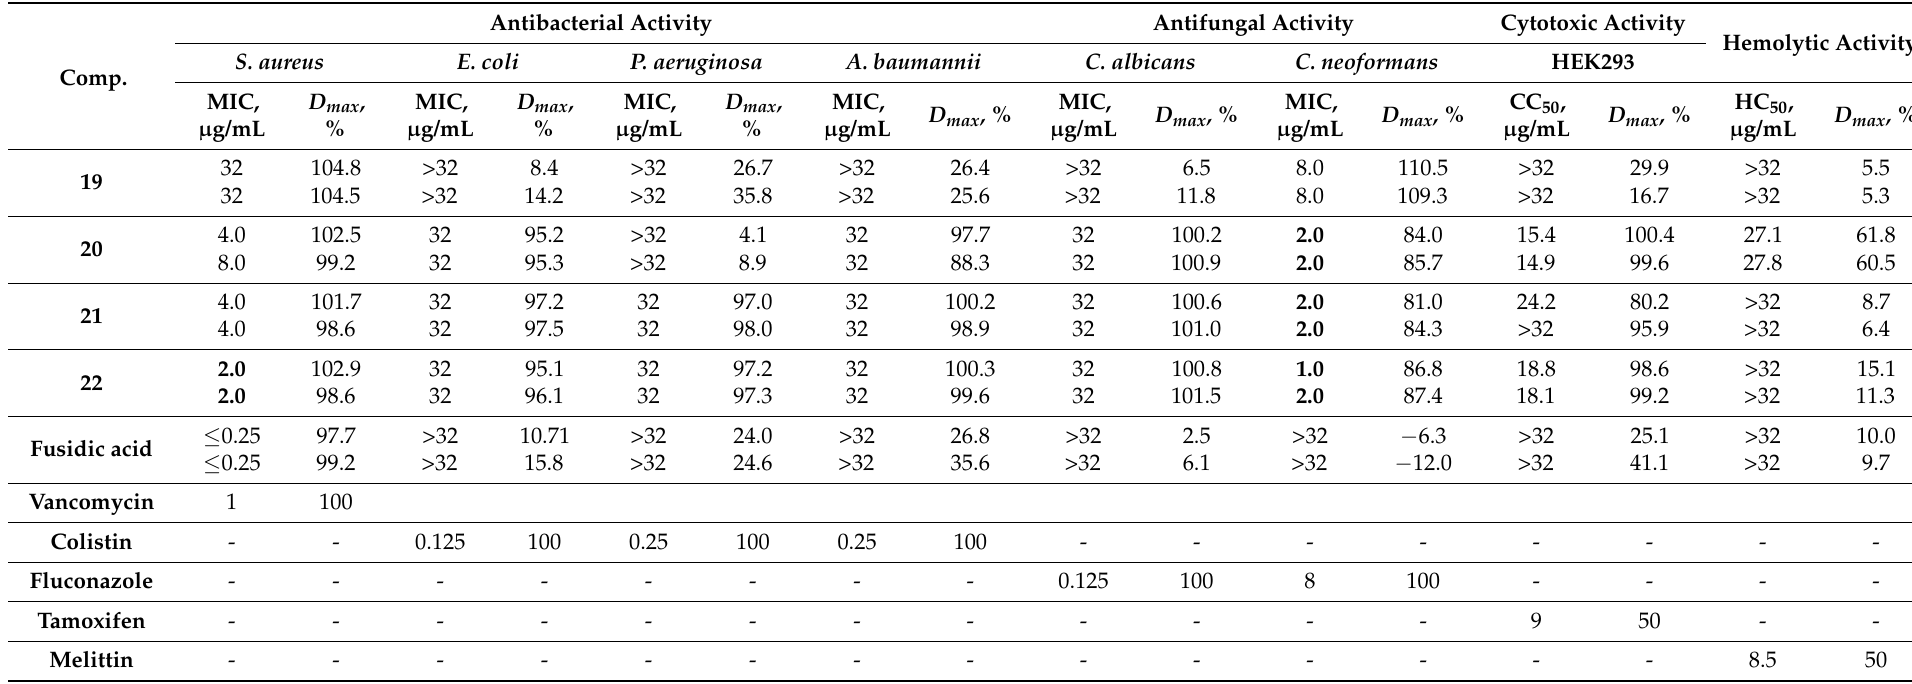
Table 3. Antibacterial, cytotoxic, and hemolytic activity of compounds 19–22 and fusidic acid.